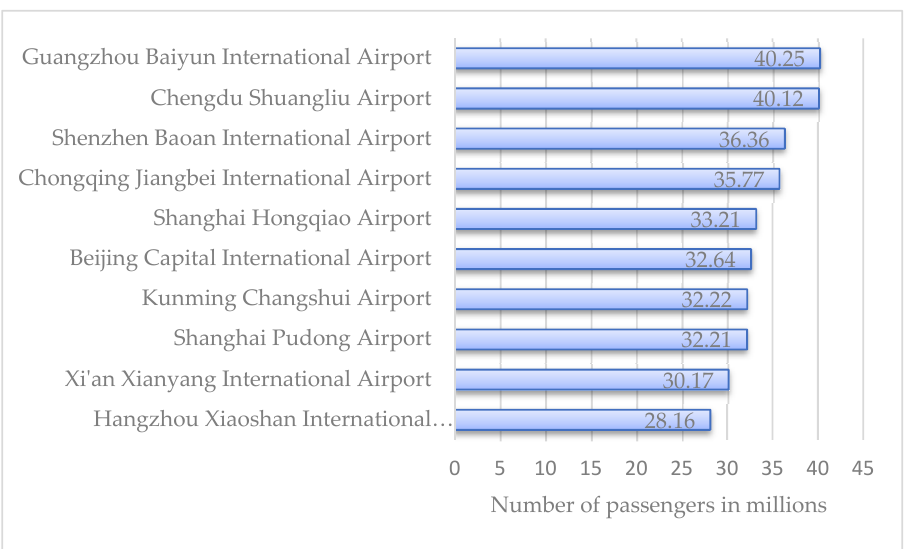
Figure 1. Top ‐ ten leading airports in mainland China in 2021, by passenger throughput. Figure 1. Top-ten leading airports in mainland China in 2021, by passenger